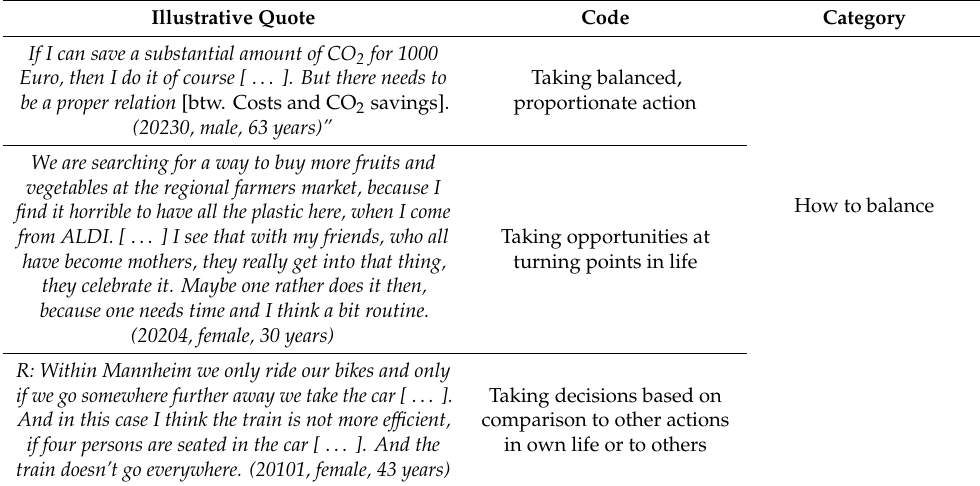
Table 8. Illustrative quotes on how participants approached the balancing